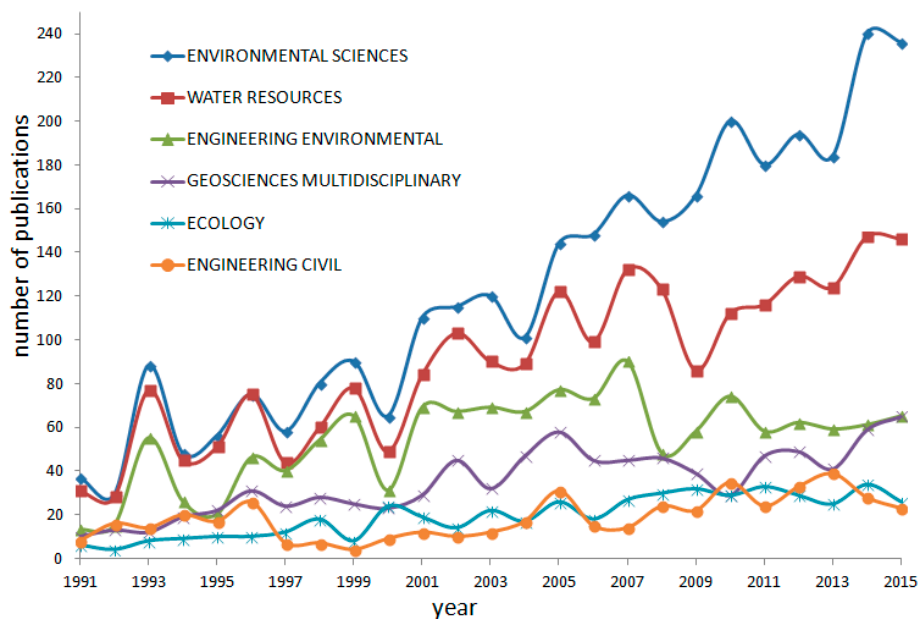
Figure 1. The growth trends of the top 6 Web of Science subject categories.